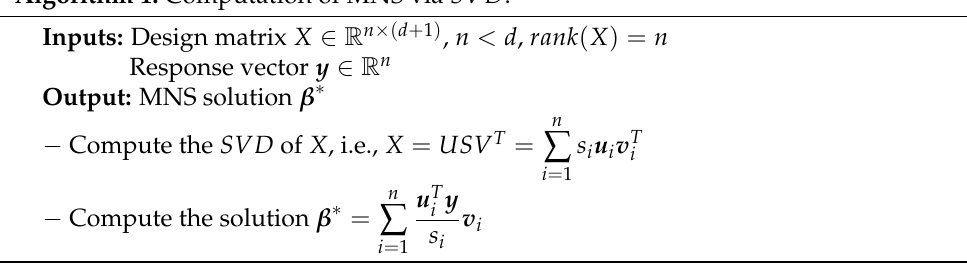
Algorithm 1: Computation of MNS via SVD